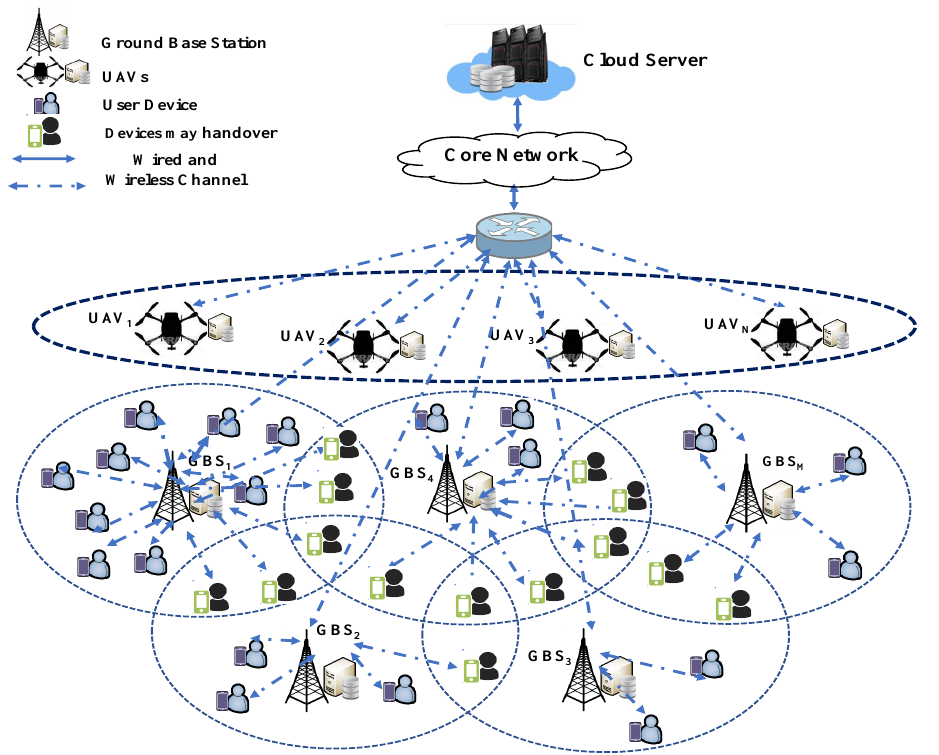
Figure 1. System